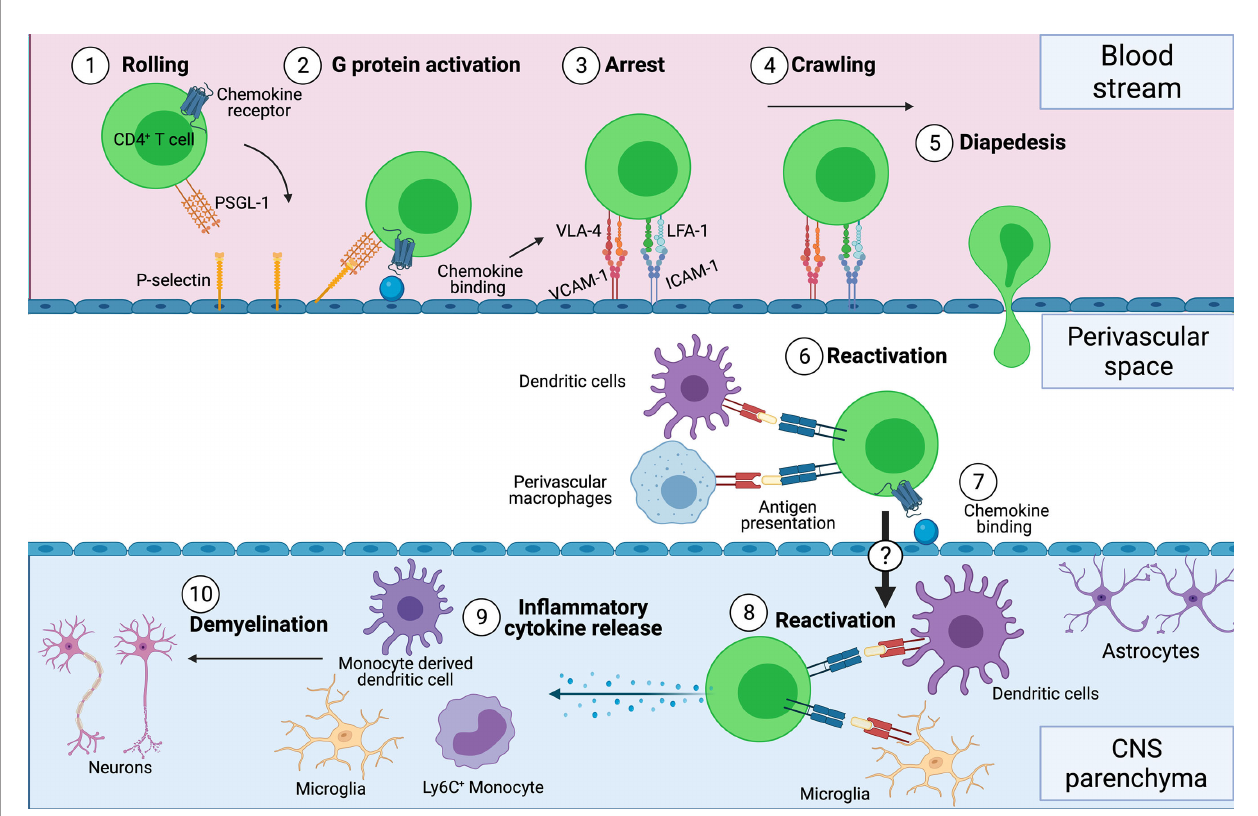
FIGURE 1 | T cell recruitment into the CNS during neuroin fl ammation. (1) After activation in the periphery, CD4 + T cells roll across the surface of the blood vessel in a process mediated by P-selectin and PSGL-1 interactions. (2) Binding of chemokine receptors to chemokines expressed on the surface of the endothelial cells activate G-proteins which trigger conformational changes of the integrins VLA-4 and LFA-1, allowing for arrest (3) of the T cells to VCAM-1 and ICAM-1 respectively. (4) T cells crawl across the endothelial cells, (5) undergo diapedesis and eventually enter the perivascular space. (6) Perivascular macrophages and dendritic cells reactivate the T cells by presenting antigen, (7) which allows T cells to migrate into the CNS parenchyma. (8-10) Once in the parenchyma, T cells can be reactivated by antigen presenting cells and release in fl ammatory cytokines such as GM-CSF which activates and recruits Ly6C + monocytes and monocyte-derived dendritic cells that drive demyelination. Figure was created using